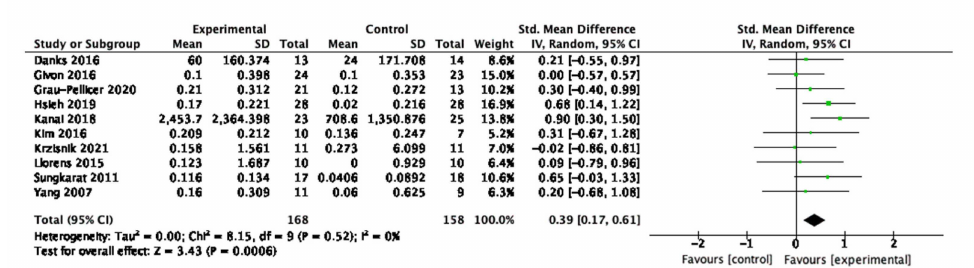
Figure 3. Meta-analysis results for physical